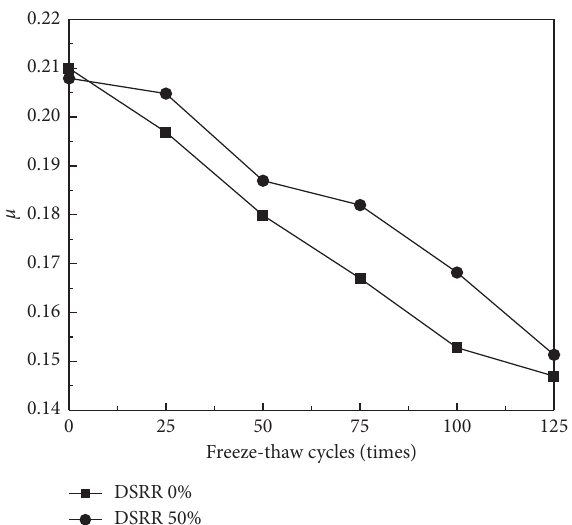
Figure 13: Relation between Poisson’s ratio ( σ / σ cycles